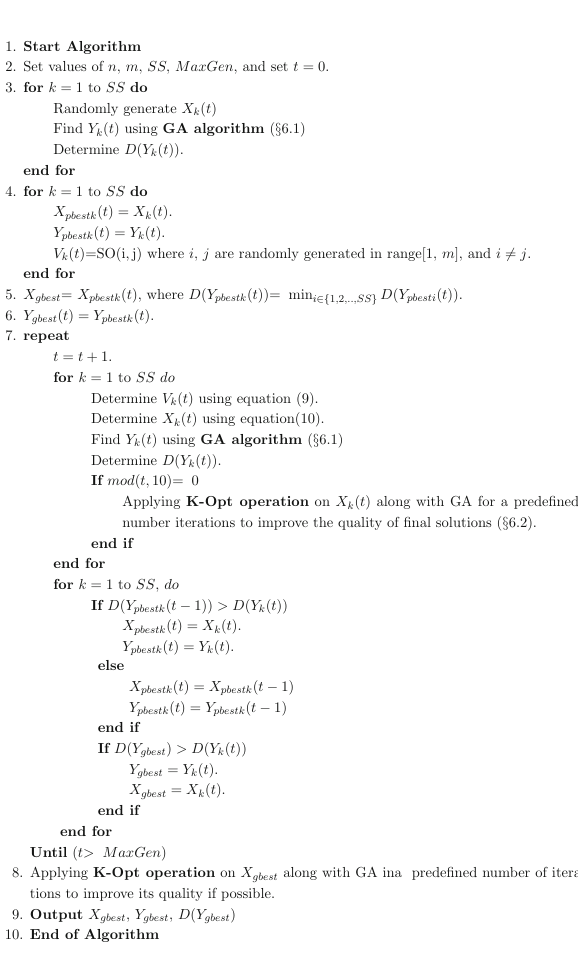
groups to find the optimal path corresponding to a sequence of groups X k ( t ) Inthealgorithm,cistheiterationcounter,Maxgenisthemax- imum number of iterations, pc is the probability of crossover, and pm is the probability of